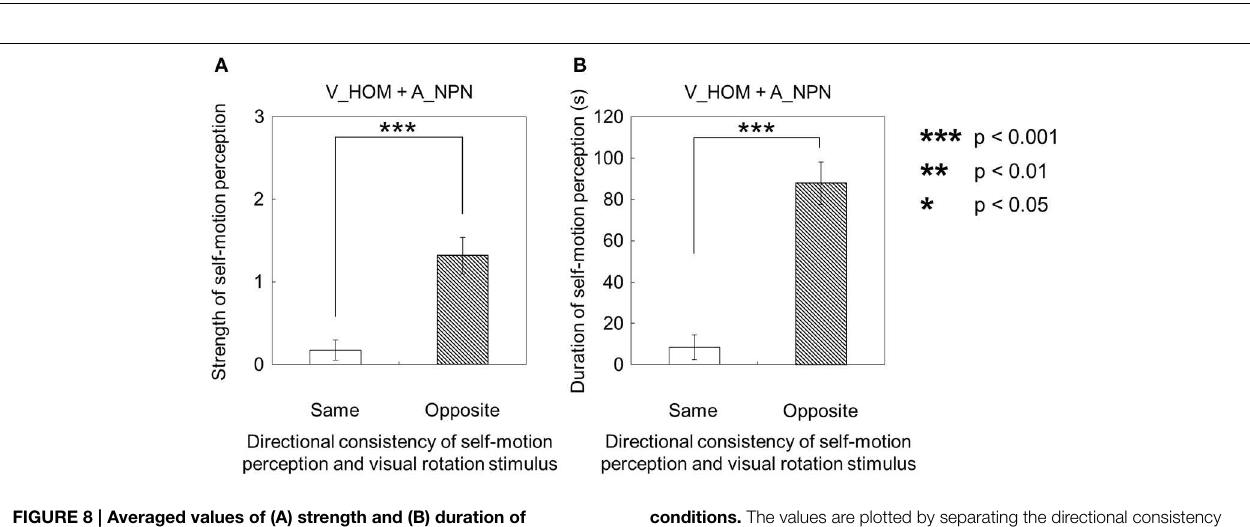
(A_HOM). The values are plotted the directional consistency of self-motion perception and auditory rotation stimulus. The error bars represent standard error (SE).